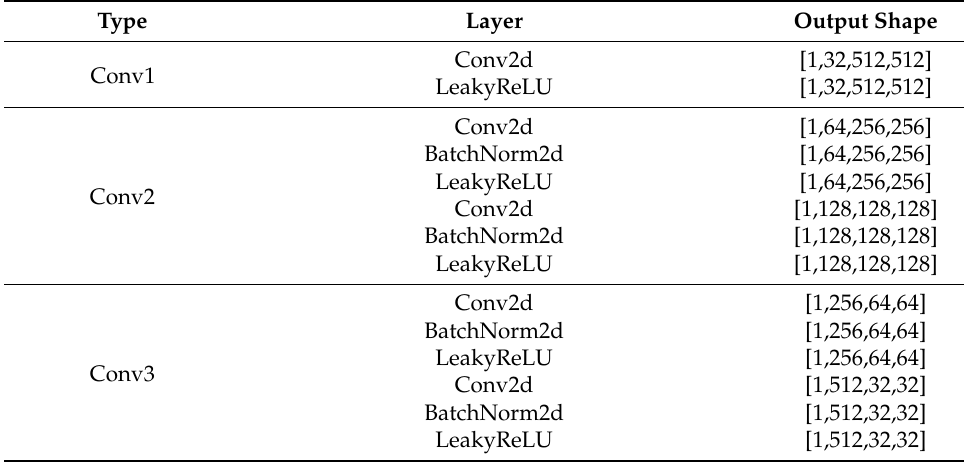
Table 2. The framework of discriminator